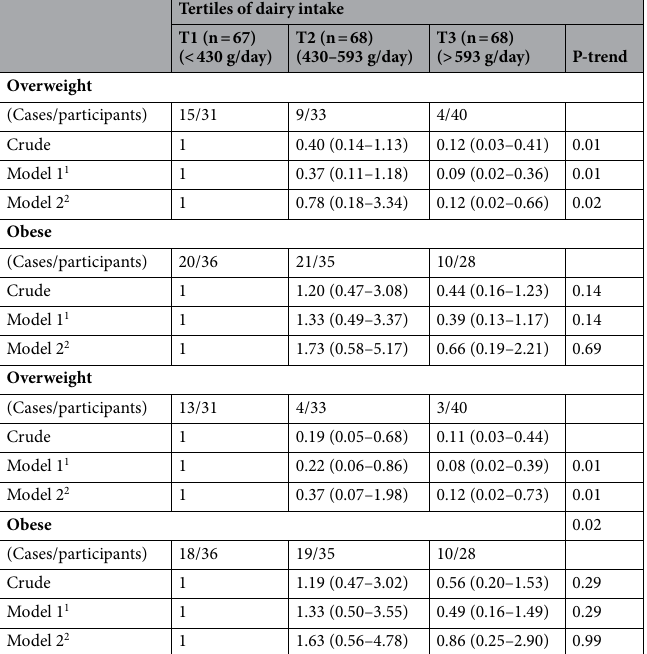
Table 3. Multivariate adjusted odds ratio (OR) and 95% confidence interval (CI) for MUO across energy- adjusted tertiles of dairy intake, stratified by BMI categories 1 . All values are odds ratios and 95% confidence intervals. 1 Model 1: Adjusted for age, sex, total energy intake, and fat intake (percent of energy). 2 Model 2: Additionally adjusted for physical activity and socioeconomic status (parental education, parental job, number of family members, having car in the family, having computer/laptop, having personal room and having